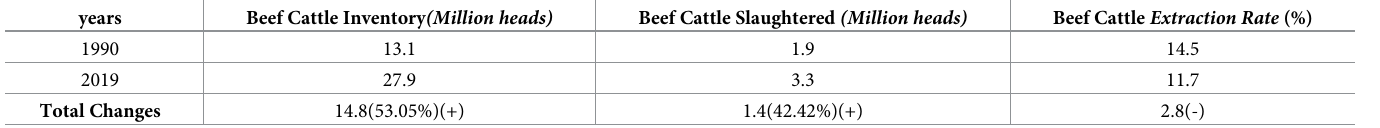
Table 2. Changes in the overall structure of beef cattle inventory, slaughtered beef cattle, and extraction rate from 1990 to